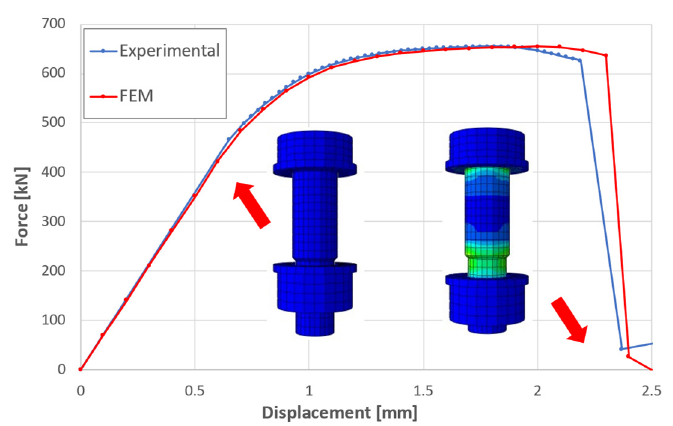
Figure 8. Comparison between the experimental and FEM monotonic test on a bolt subjected to nut stripping.